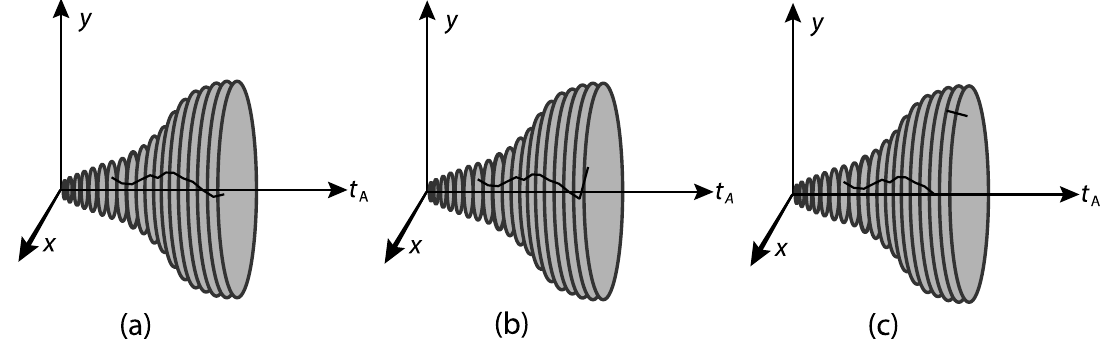
Figure 3. Two of the three spatial dimensions ( x , y ), with the one normal time dimension plotted horizontally in place of the z dimension. The entire spatial structure of the universe at a given time along the t A axis is represented by the corresponding time “slice”. ( a ) the path of a normal object, obeying the laws of physics, follows a smooth, continuous path as time increases. ( b) an object subject to a sudden, very large force. ( c ) an object violating the laws of